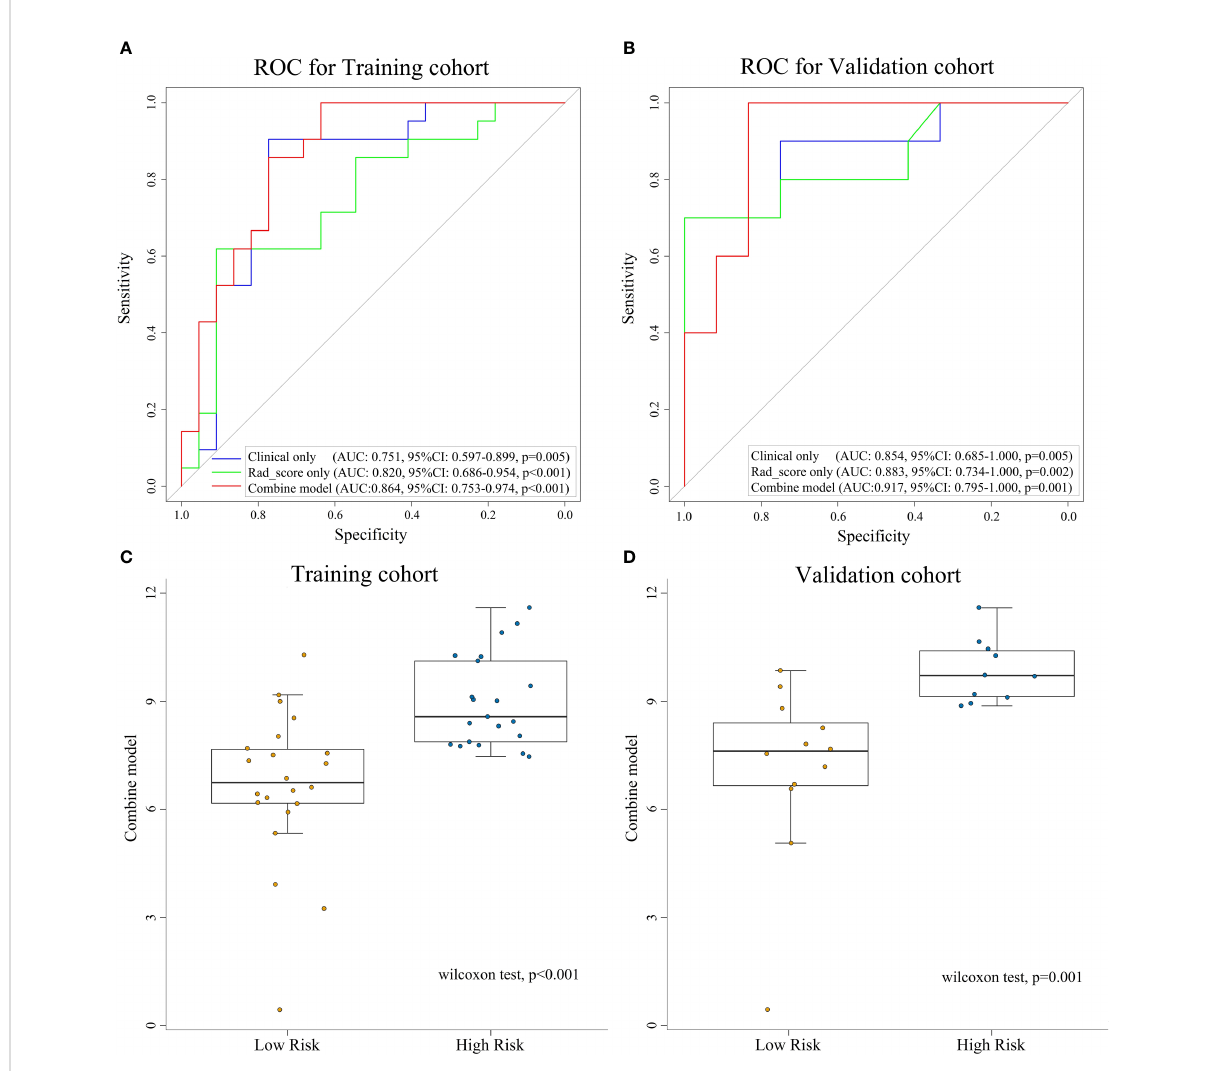
FIGURE 4 ROC curves for assessing the different performance of three models in training cohort (A) and validation cohort (B) . The box plots of combine model for low-risk and high-risk groups for training cohort (C) and validation cohort (D) . ROC, receive operation characteristic; AUC, area under the curve; CI, con fi dence interval; Rad-score, radiomic